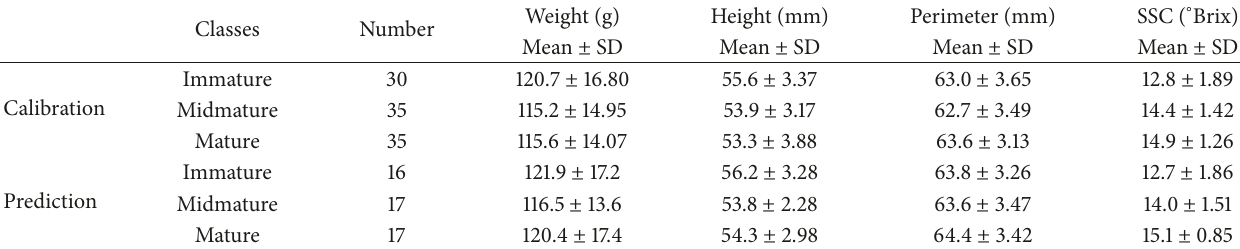
Table 1: Some physical parameters of navel oranges at three different maturity stages.